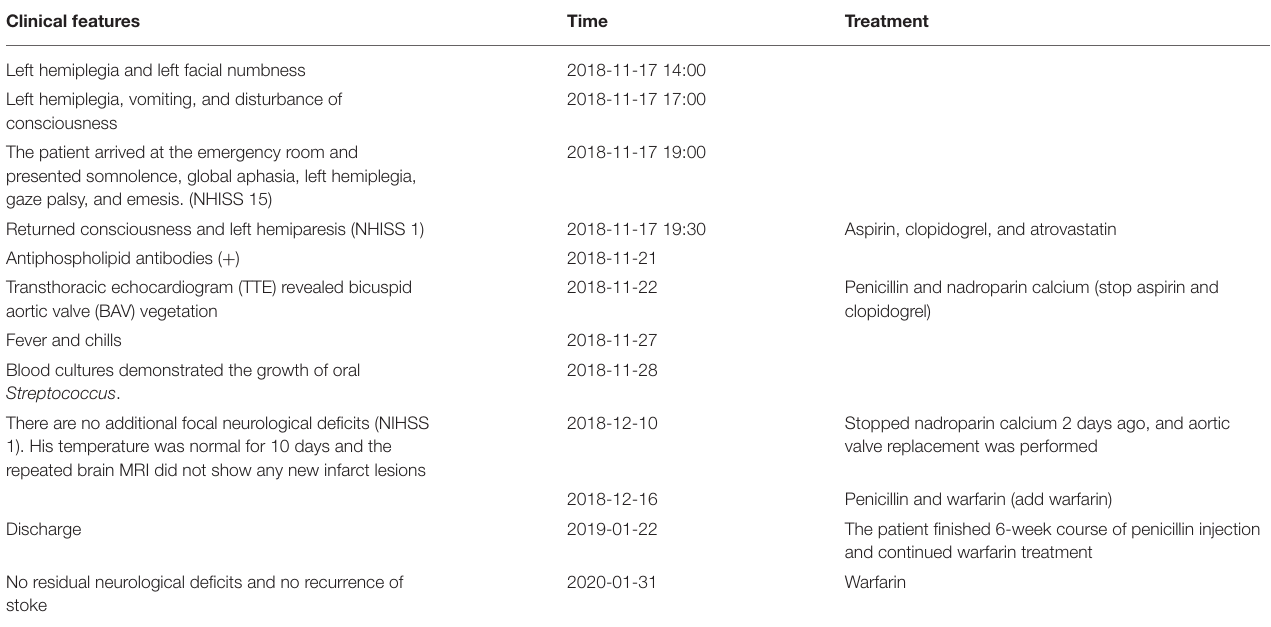
TABLE 1 | The clinical features and treatment of the patient according to the timeline. Clinical